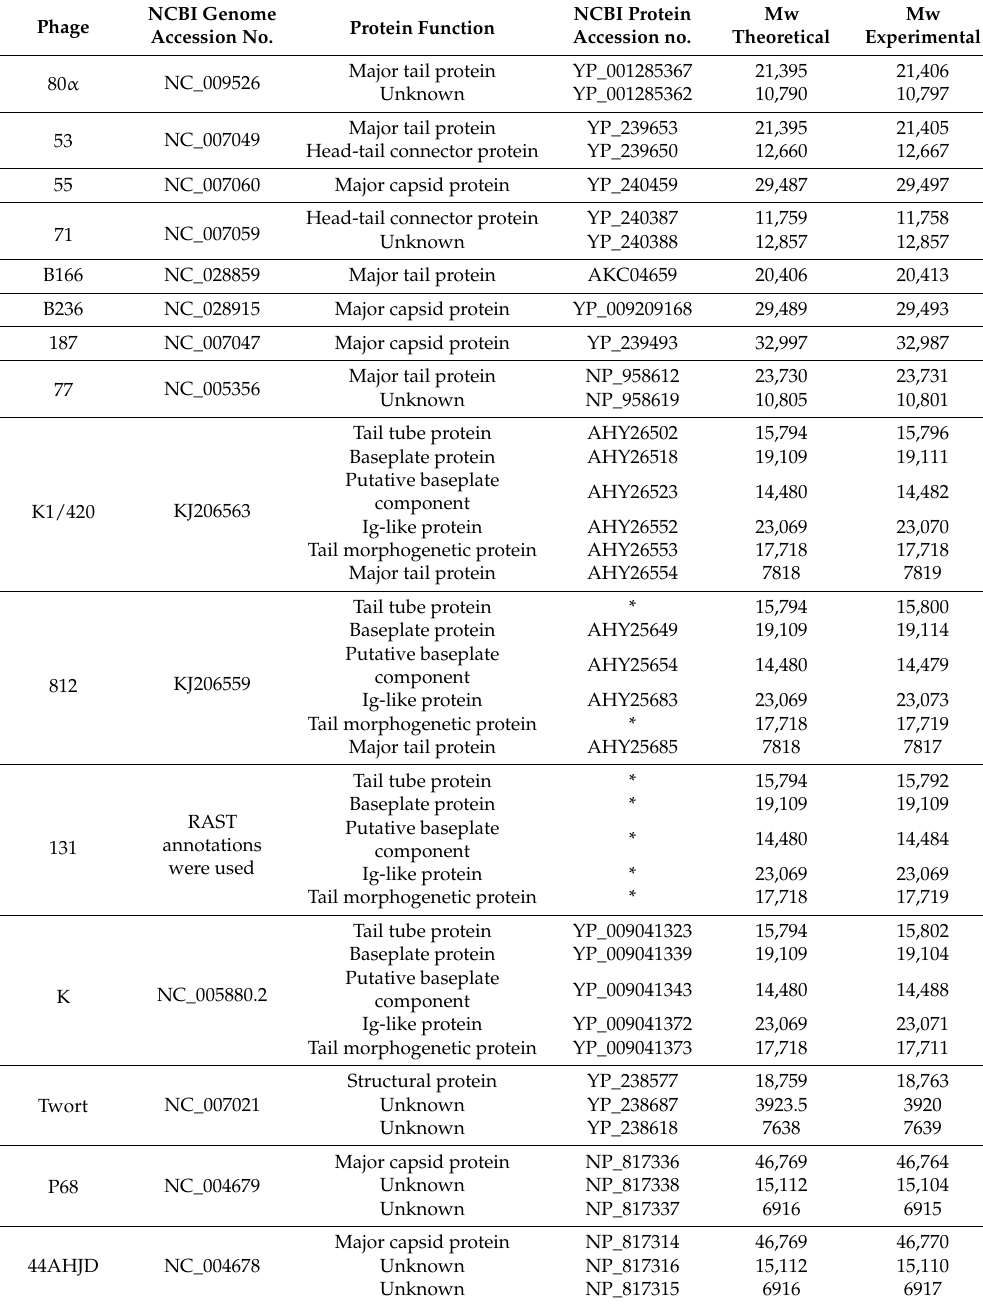
* Newly sequenced phage genomes annotated using RAST.